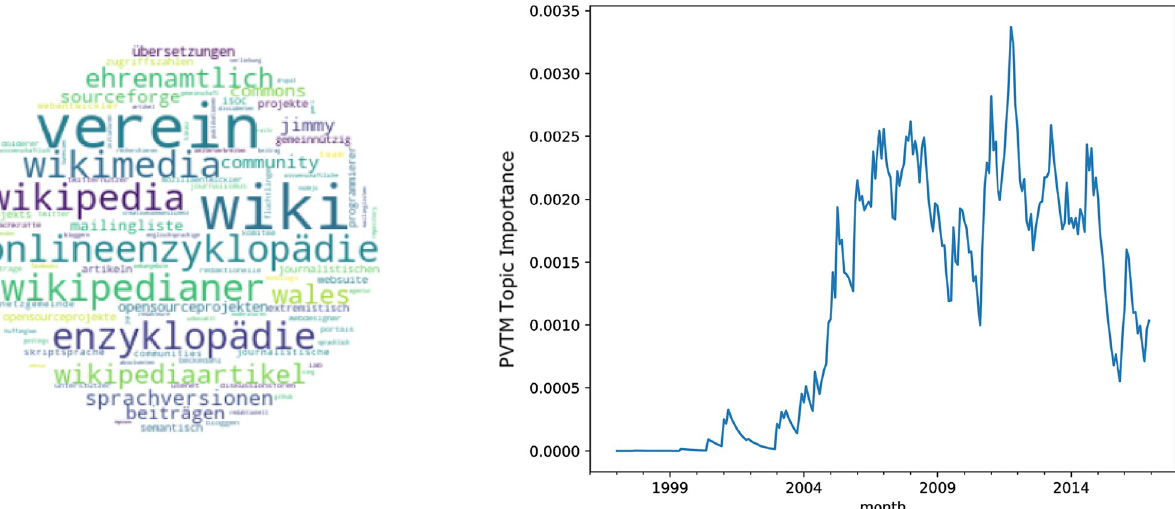
Fig 4. Topic wikipedia. A: Most relevant words. B: Monthly observations of the topic importance over time, smoothed using a 12-month exponentially weighted moving average.